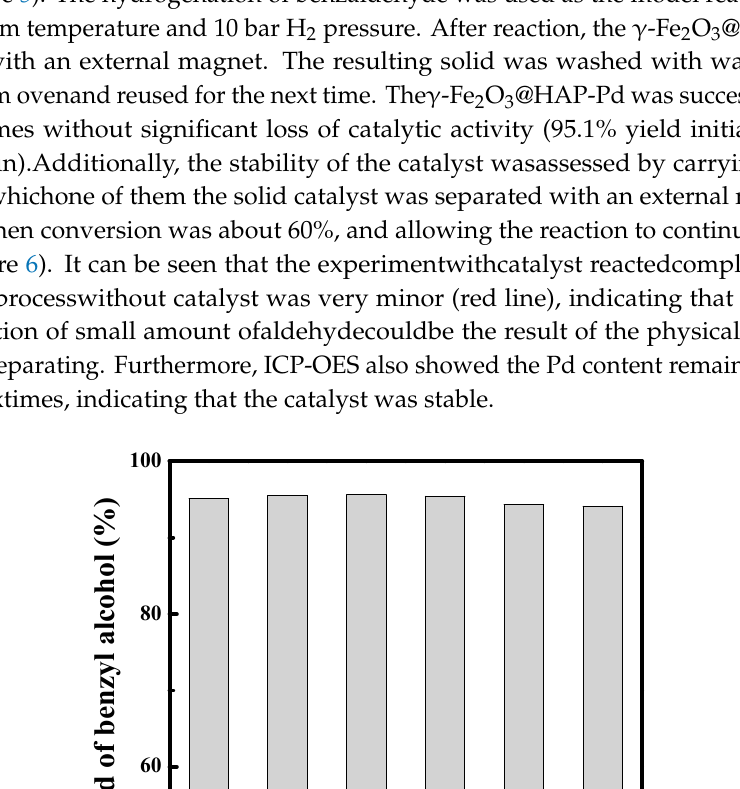
Figure 4. Time course of the deoxygenation of benzylaldehyde into toluene. Reaction conditions: benzylaldehyde (1 mmol),2 wt.% γ -Fe 2 O 3 @HAP-Pd catalyst (10 mg), H 2 O (10 mL), 2.5 bar H 2 , 70 °C.